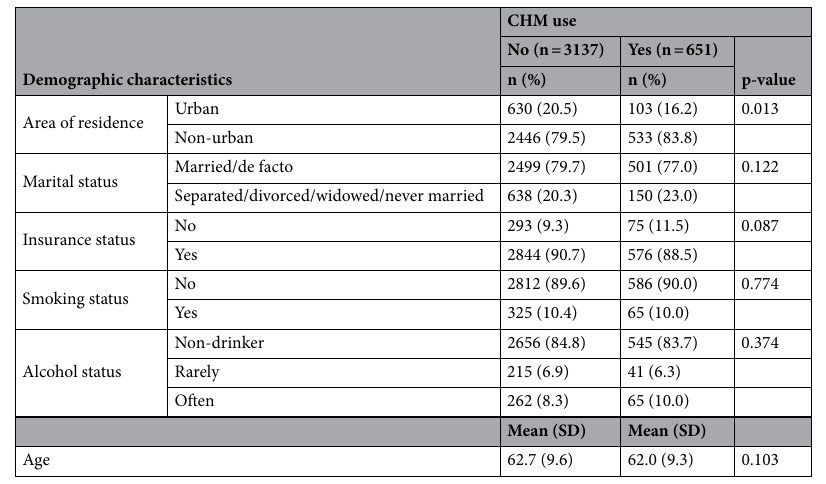
Table 1. Associations between CHM use and demographic characteristics, by Chinese women with